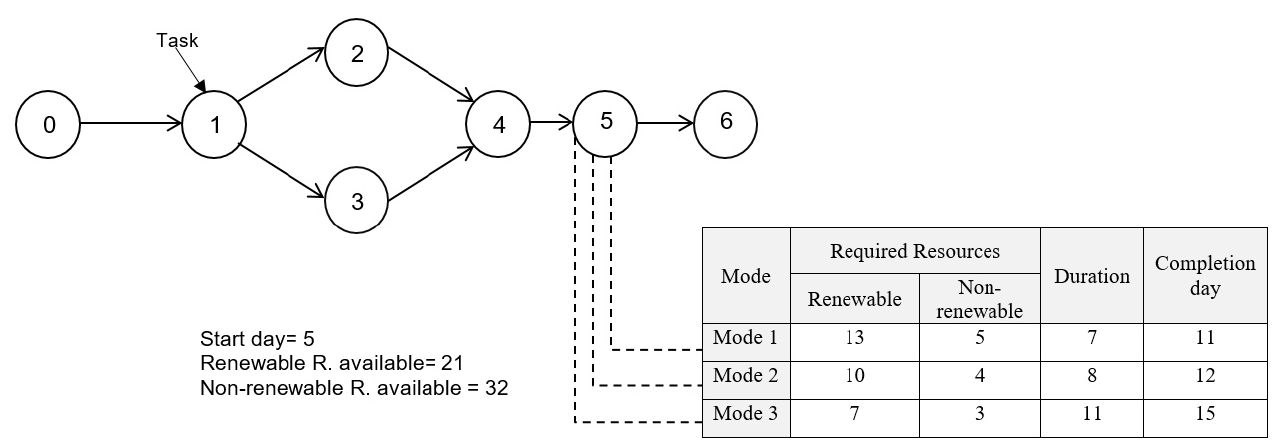
Figure 1 . MMRCPSP proposal